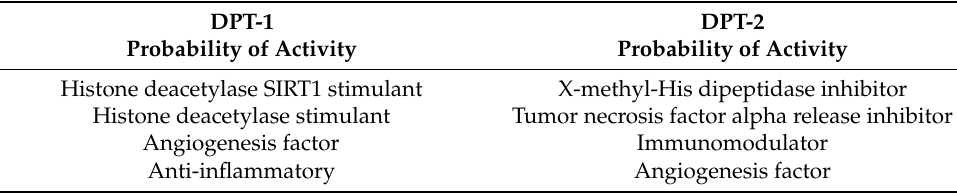
Table 4. Probability of activities of DPT-1 and DPT-2 using PASS Program